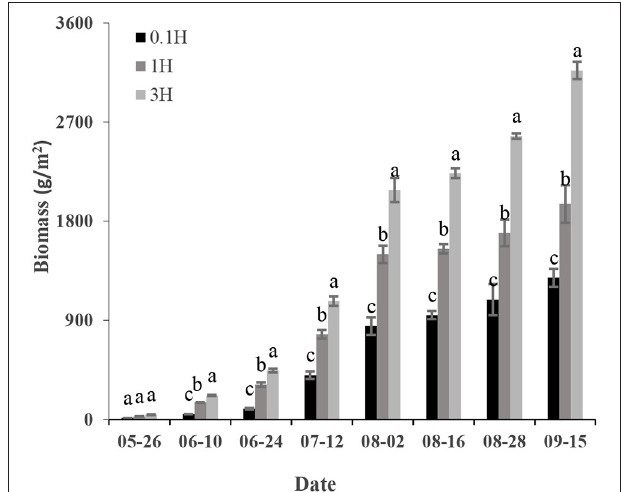
FIGURE 3 | Variation in temperature and precipitation in the experimental site during the whole growth period of cotton.